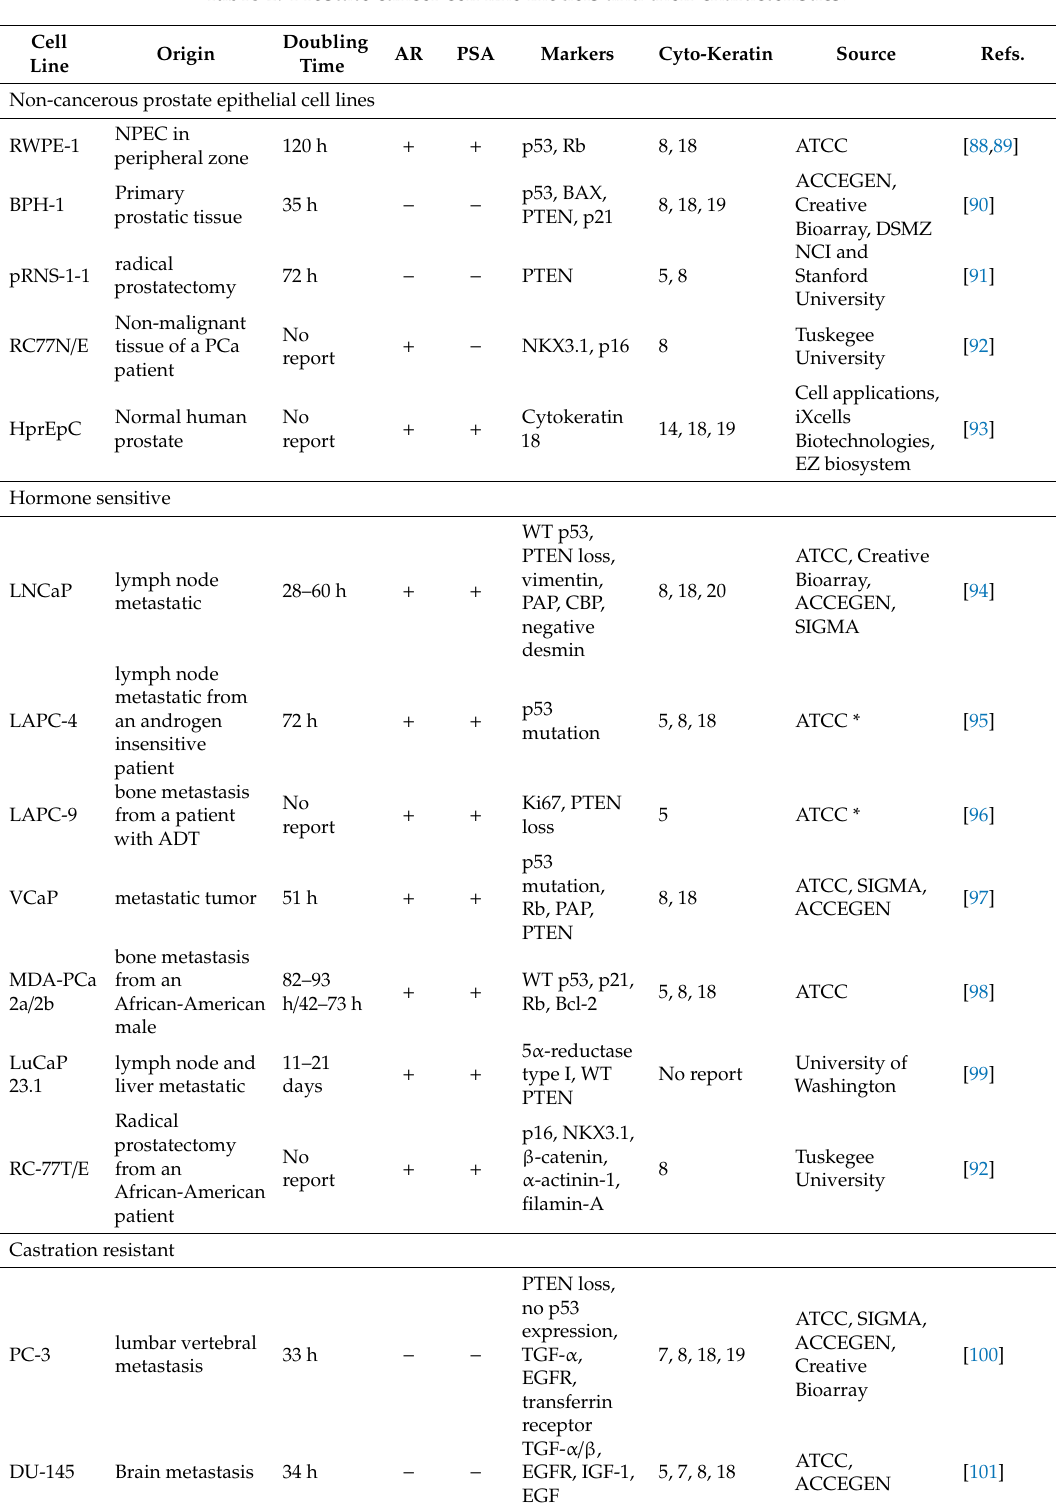
Table 1. Prostate cancer cell line models and their